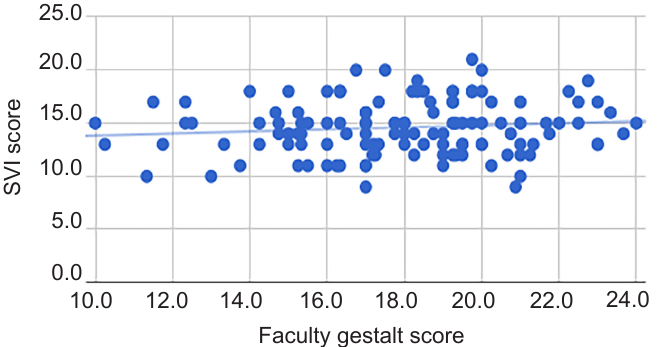
Figure 2. Scatter plot of transformed Standardized Video Interview (SVI) score vs. interview score (r (123)=0.09, s with line of best fit.